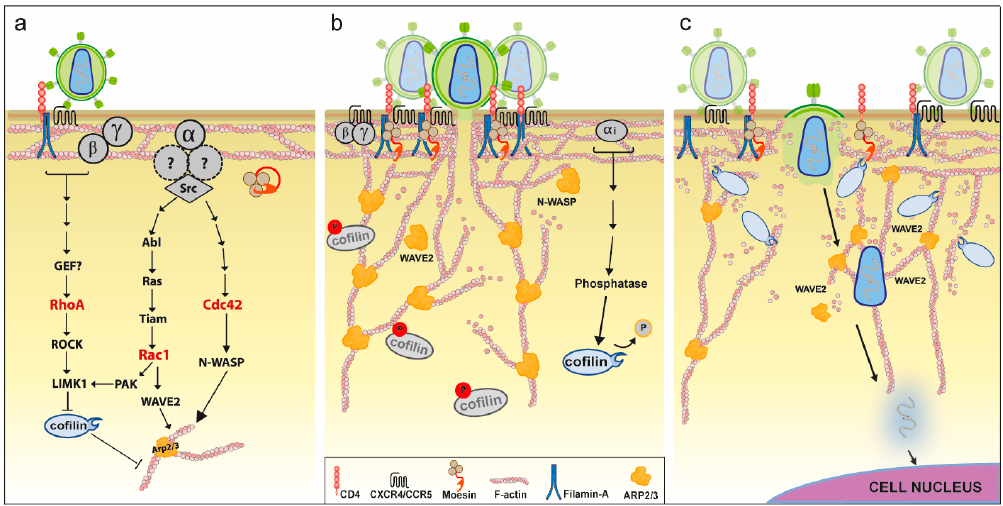
Figure 2. Hypothetical model of the role of manipulated actin dynamics for inbound HIV infection in T-cells. ( a ) Early signaling events. Binding of Env to CD4 and coreceptor molecules (CXCR4/CCR5) initiates signaling via the receptor-coupled G-protein. G α i /G α q signaling via Src activates both Rac1 and Cdc42, which in turn activate downstream nucleation-promoting factors (NPFs) that stimulate actin polymerization activity by the Arp2/3 complex. Env binding to CD4 also triggers RhoA activation in a filamin-A-dependent manner, and results in moesin activating phosphorylation. Both RhoA and Rac1 lead to cofilin inactivation via phosphorylation by LIMK1. Rho-GTPases are shown in red; ( b ) receptor capping. Stimulation of Arp2/3 by active NPFs and simultaneous inhibition of cofilin leads to increased cortical actin polymerization. This results in aggregation of CD4 and CXCR4 receptors, which requires linking of these molecules to actin filaments by filamin-A and moesin. Enhanced colocalization of these receptors near Env promotes viral entry (fusion), with actin polymerization participating in fusion-pore formation and expansion. Delayed Env-CXCR4 signaling via G α i leads to cofilin activating dephosphorylation by a currently undefined mechanism; ( c ) intracellular transport. After virus–cell fusion, transport of HIV to the nucleus is limited by the dense cortical actin network. Cofilin activation results in local actin depolymerization that allows passage of the viral core through the actin cortex. Transport of the pre-integration complex towards the nucleus is thought to involve Arp2/3-mediated actin polymerization. * Of note, interfering with the Rho-GTPases shown in Red, or any of the molecules depicted in the legend has been reported to impair inbound HIV infection.